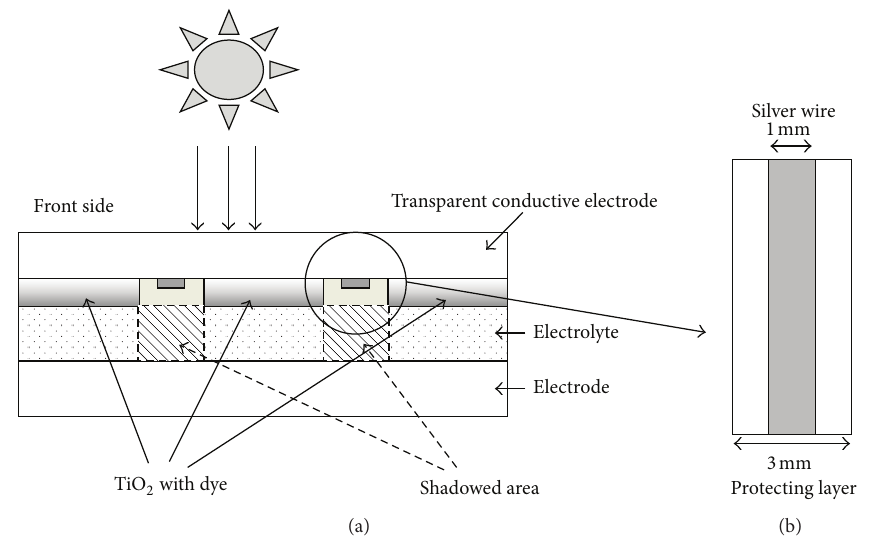
Figure 1: Schematic diagram of a dye-sensitized solar cell: (a) a side view, (b) an enlarged top view of a collector electrode portion.